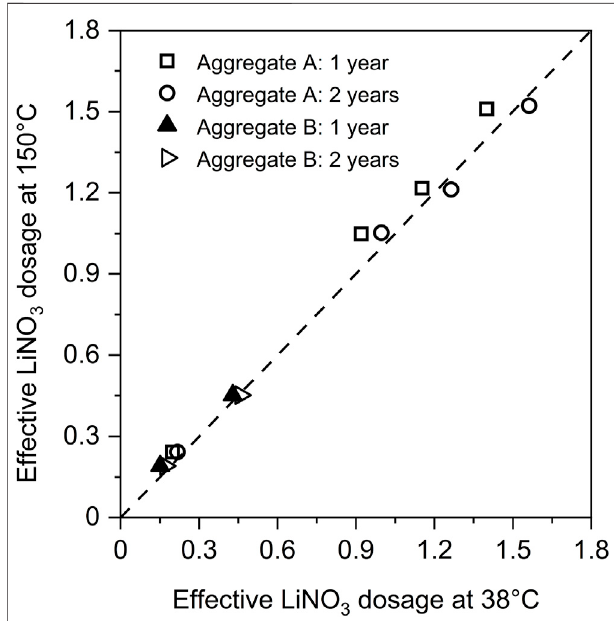
FIGURE6| Comparison betweentheeffective dosages oflithium nitrate for mitigating ASR obtained from the ultra-accelerated concrete prism test (150 ° C) and the concrete prism test at 38 ° C and 100% RH. Data from (Berra et al., 2003).